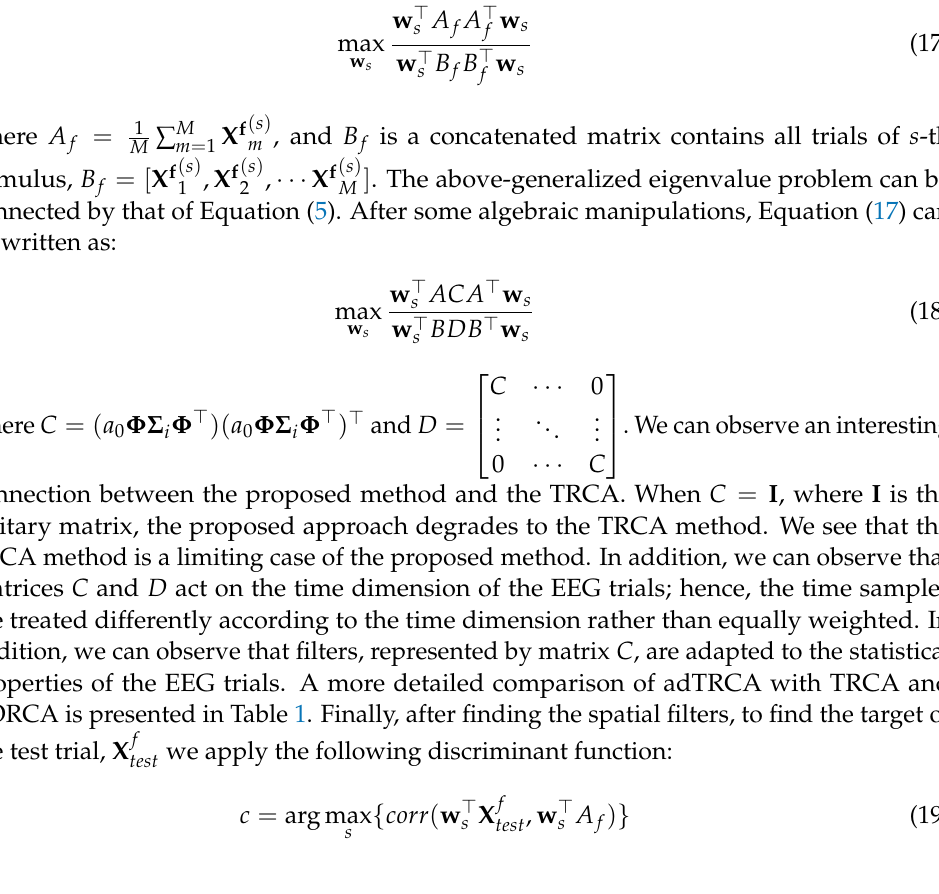
Table 1. Differences in the objective function of the proposed method (adTRCA) with respect to TRCA [24] and CORCA [29]. TRCA